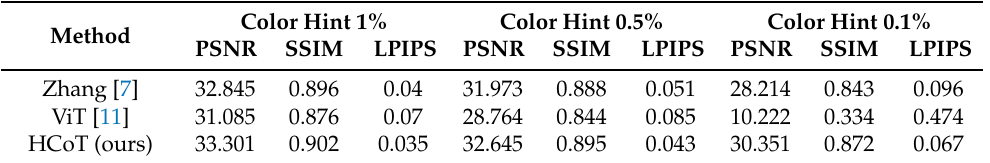
Table 2. Experimental results by color hint